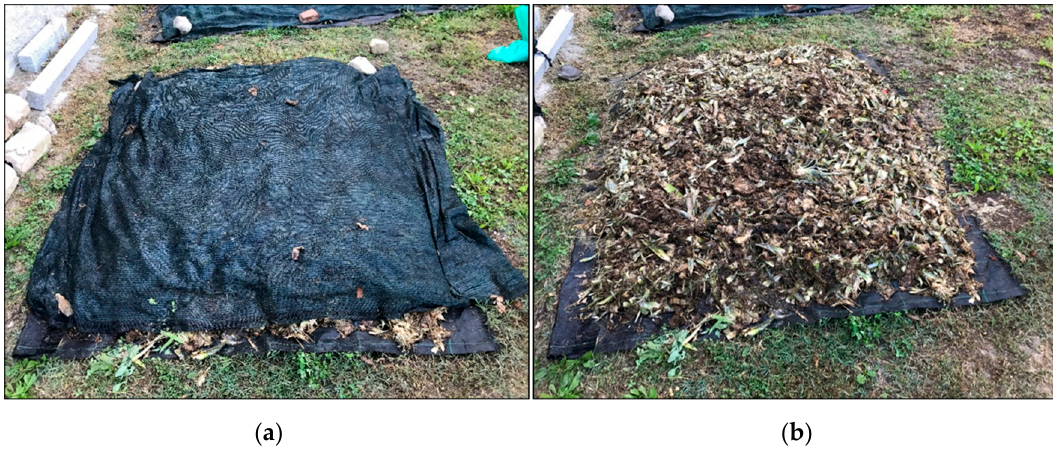
Figure 1. ( a ) Covered earthworm rearing; ( b ) Uncovered earthworm rearing with visible growth